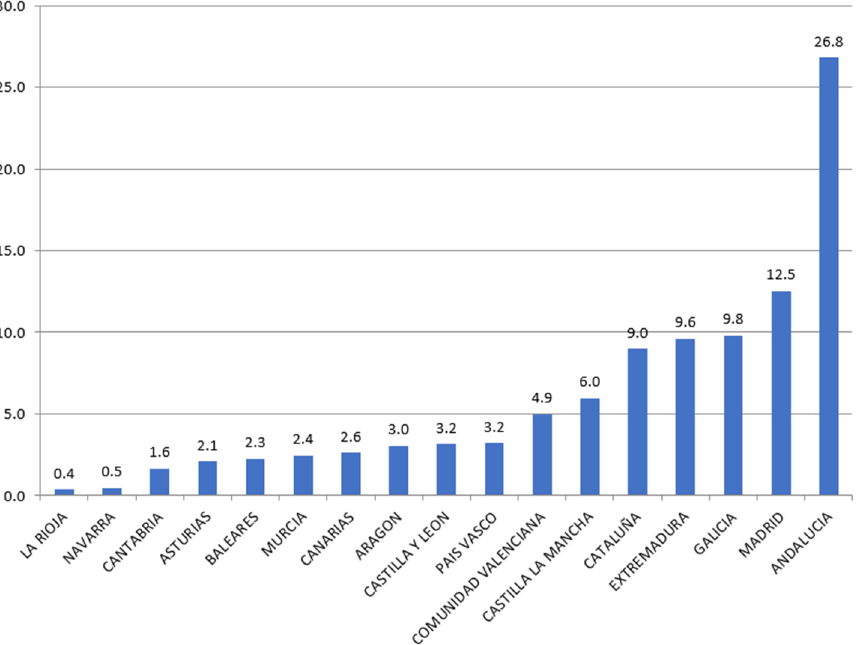
Figure 2. Distribution of ESF Funds by region. Period 2014–2019 (%). Source: European Commission and own calculations.